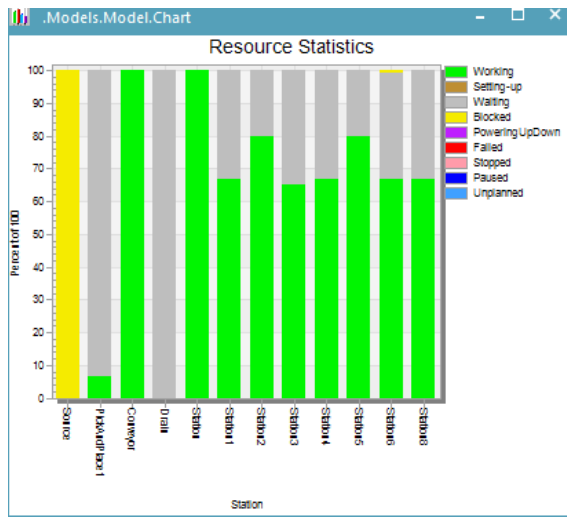
Figure 9. Statistics concerning the work of machines in the production process.